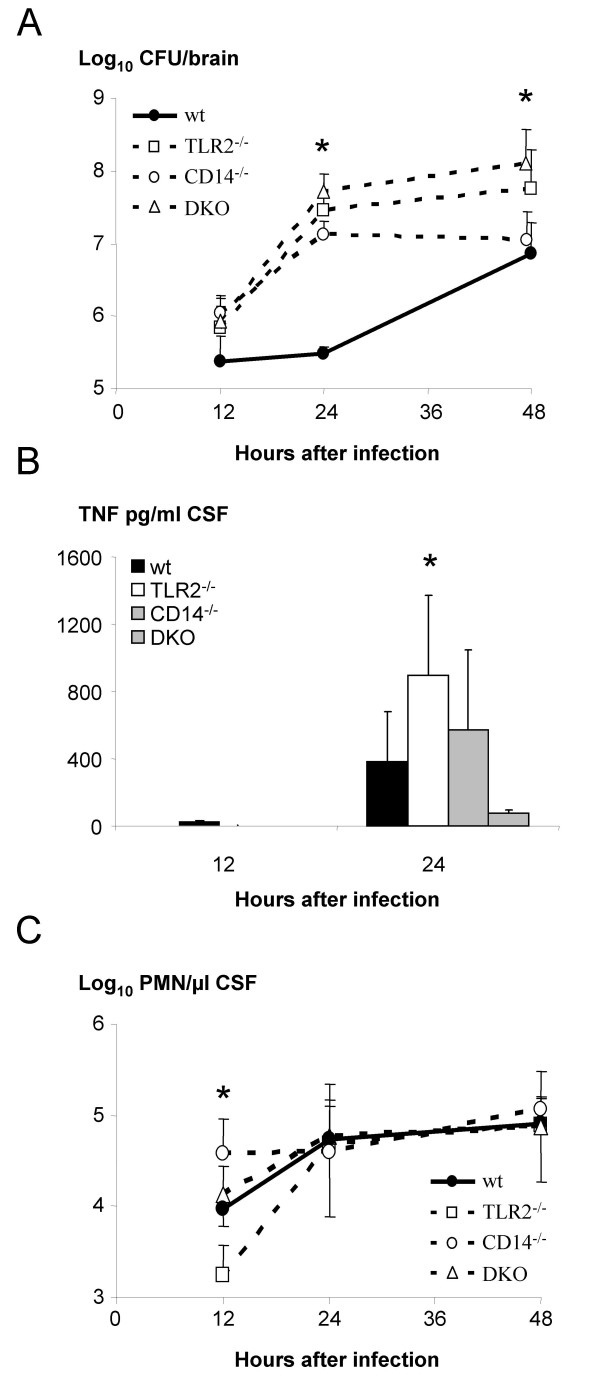
A) Bacterial numbers in brain 12, 24 and 48 h after infection with 3 × 103 CFU of S. pneumoniae in wt (n = 18), TLR2-/- (n = 18), CD14-/- (n = 17) and TLR2-/-/CD14-/- (n = 6) mice. Median values and 25–75% spread (p < 0.02, ANOVA). B) TNF levels in CSF in wt (n = 21), TLR2-/- (n = 13), CD14-/- (n = 14) and TLR2-/-/CD14-/- (n = 6) mice 12 and 24 h after infection. Mean values ± SD (p < 0.02, ANOVA). C) Leukocyte numbers in CSF in wt (n = 15), TLR2-/- (n = 10), CD14-/- (n = 14) and TLR2-/-/CD14-/- (n = 6) mice 12 to 48 h after infection. Median values (p < 0.02, ANOVA).